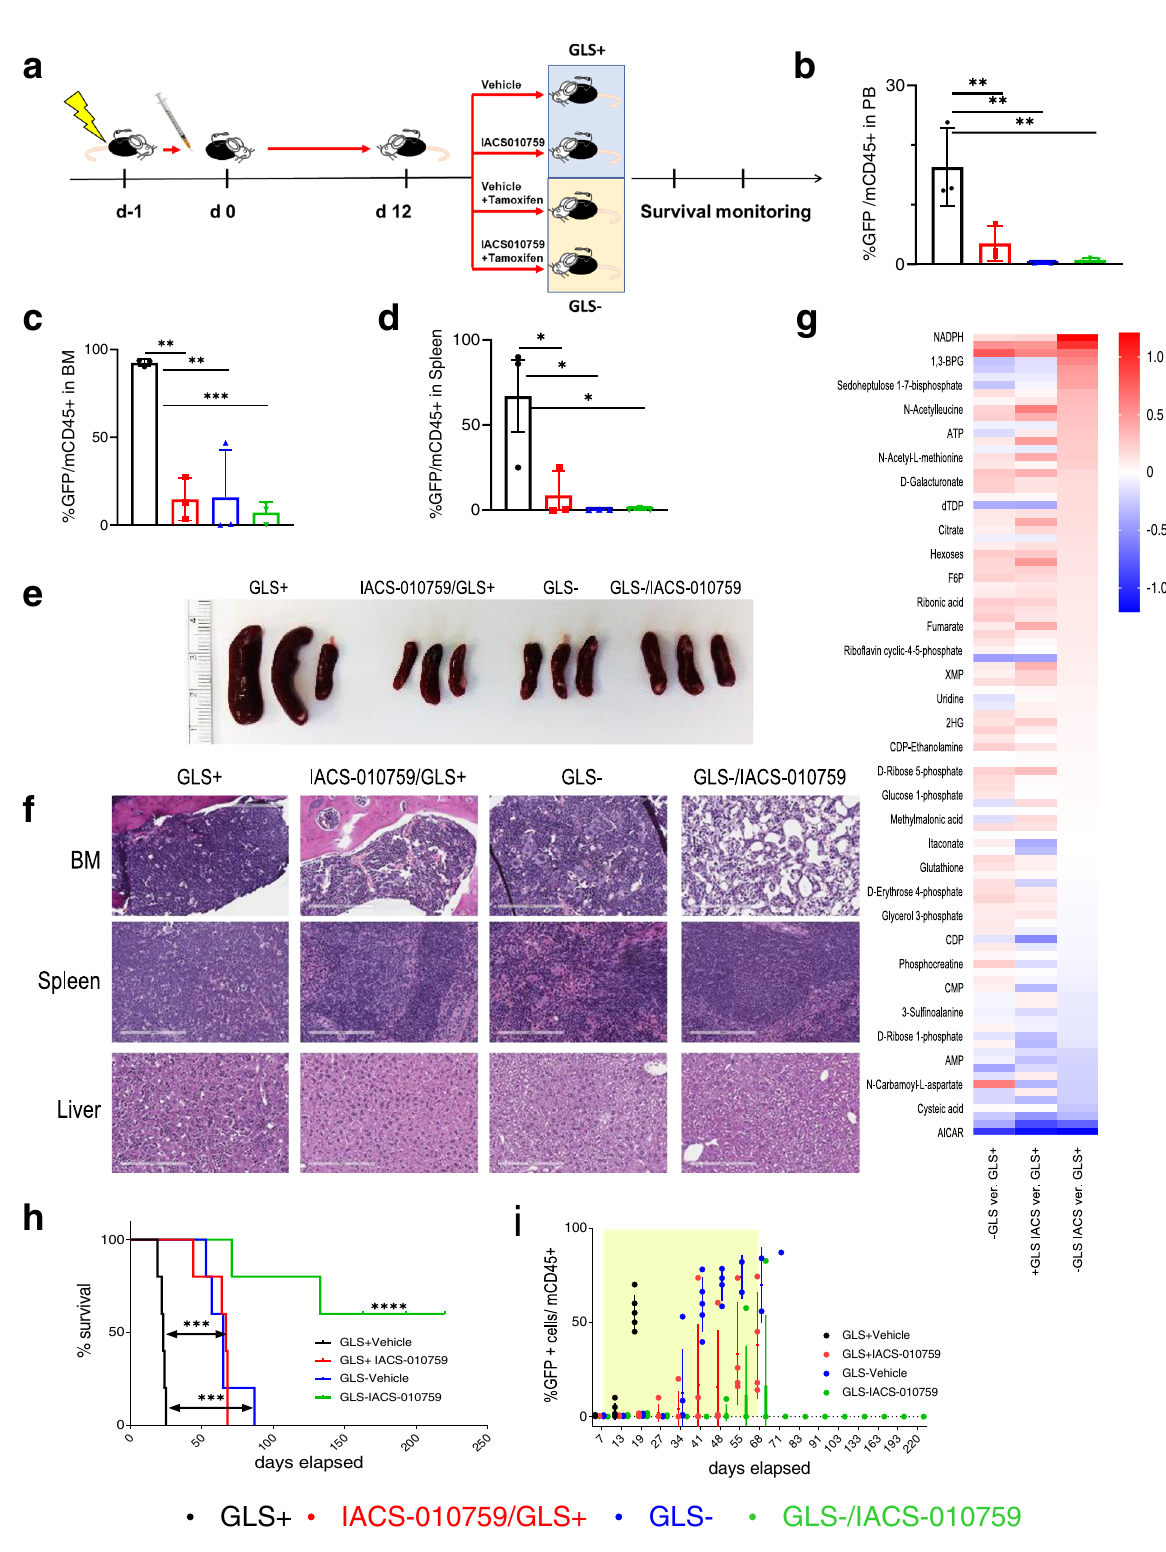
combined with OxPhos-i. Dexamethasone and vincristine increased OCR signi fi cantly ( p = 0.0001; Supplementary Fig. 23a) and led to moderate reductions of cell viability (Supplementary Fig. 23b, c). L -asparaginase similarly induced OCR ( p = 0.0001; Supplementary Fig. 23a) but decreased viability potently as monotherapy (Supplementary Fig. 23d). When combined with OxPhos-i, all drugs synergized to reduce viability, with the